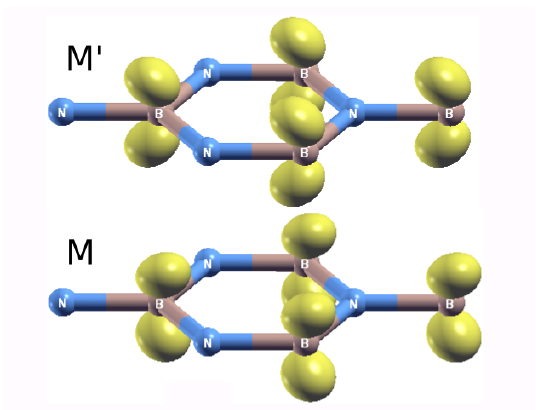
Figure 4: [ Color online ] The orbitals at M and M (cid:48) . Notice that in principle there is another orbital along the third bonds, equivalent to the one at M not showed